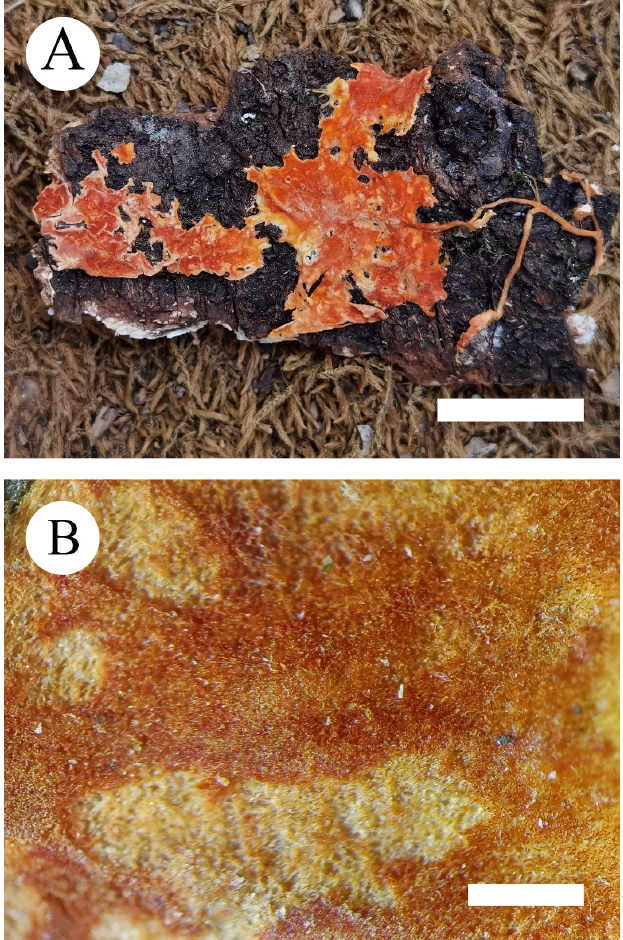
Figure 5. Basidiomata of Phanerochaete rhizomorpha (holotype) Bars: ( A ) = 2 cm and ( B ) = 1 mm.